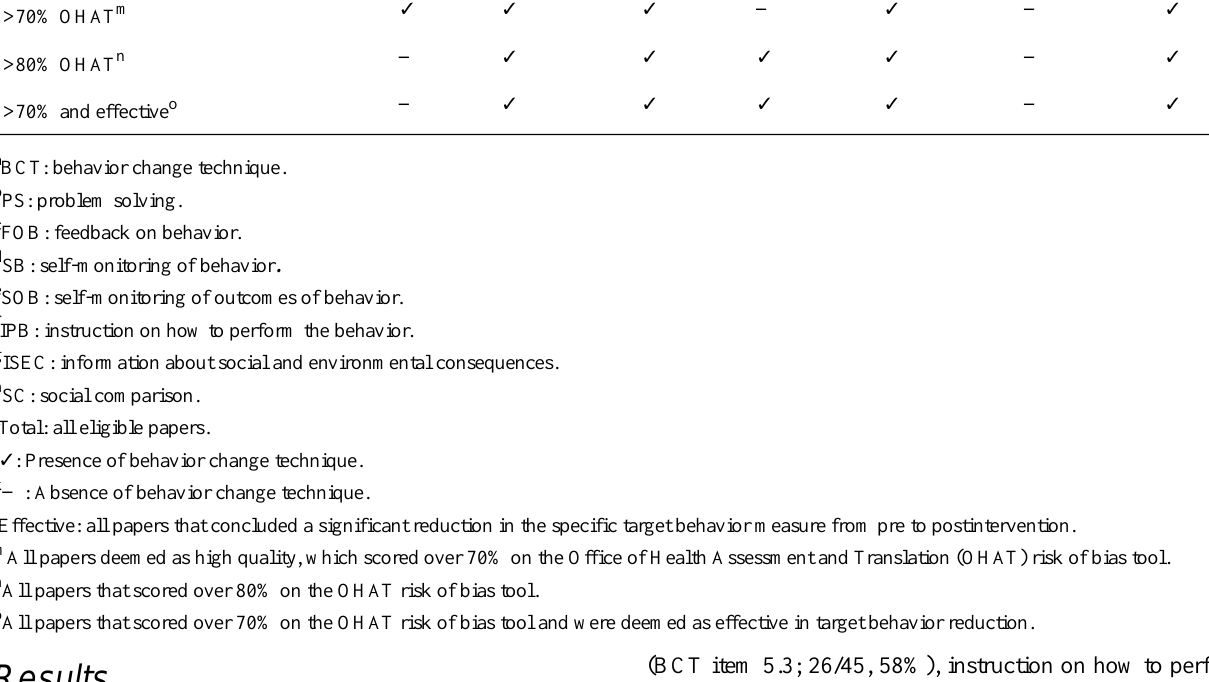
BCT a itemFrequency count